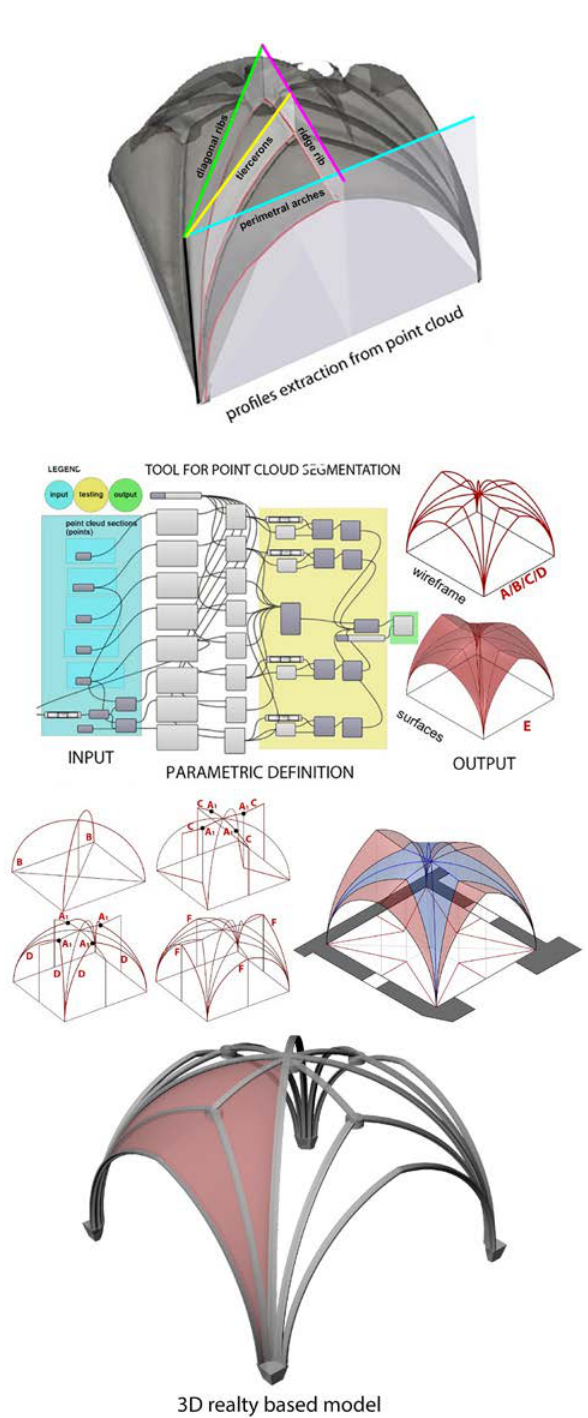
Figure 14 . Parametric tool for realty based model